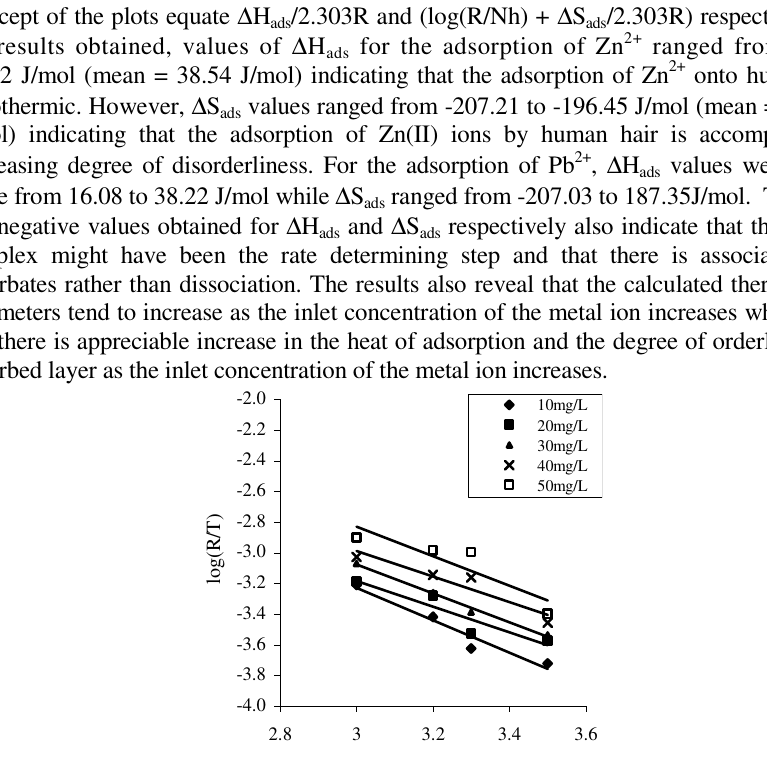
Figure 7. Transition state plot for the adsorption of various concentrations of Zn 2+ onto human hair